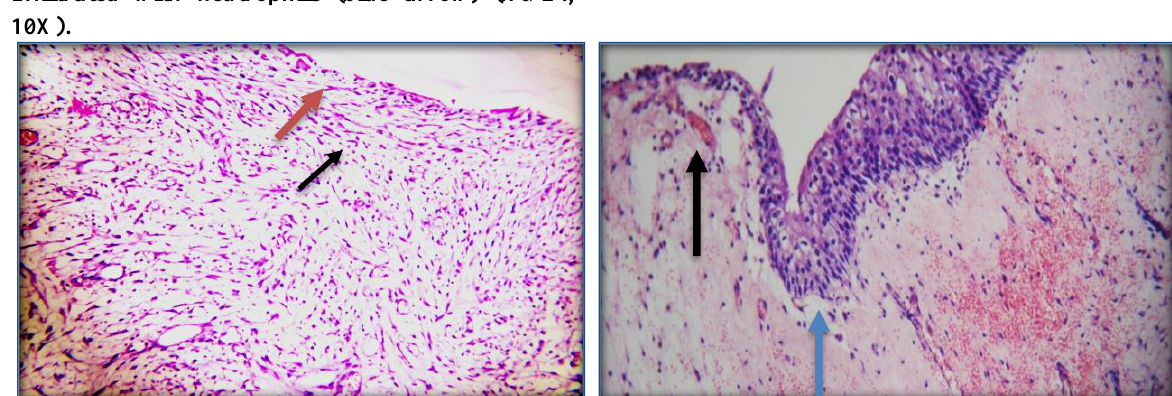
Figure, 8: Dog urinary bladder closed by inverting pattern, 14 days post-surgery, show's, proliferation of highly cellular granulation tissue (black arrow) beneath the surface of mucosa (red arrow) (H&E.,40X).